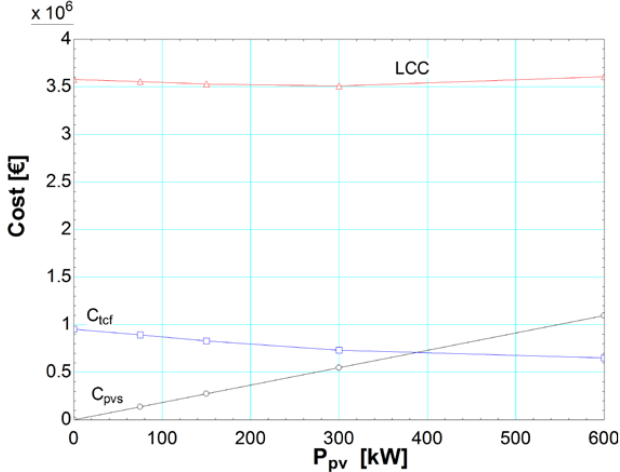
Figure 9. Parametric study: cost analysis for different photovoltaic subsystem capacities ranging from 0 to 600 kW e .